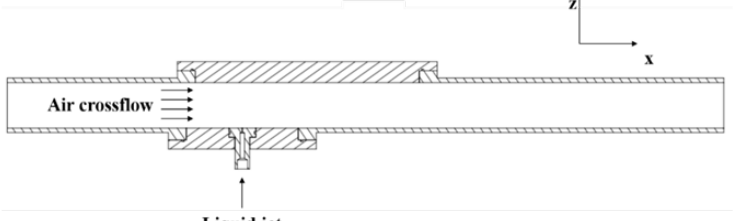
Figure 1. Schematic of experimental apparatus. Figure 2. Schematic of the test section.